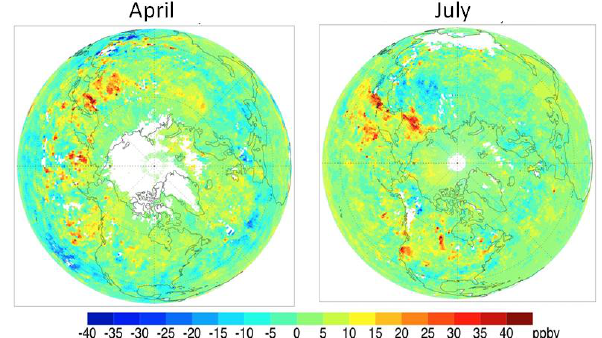
Figure 3. Monthly mean anomalies of CO columns from MOPITT retrievals for April and July 2008 relative to the 2000-2008 record. Fig. 3. Monthly mean anomalies of CO column mixing ratios from MOPITT retrievals (V4) for April and July 2008 relative to the 2000-2008